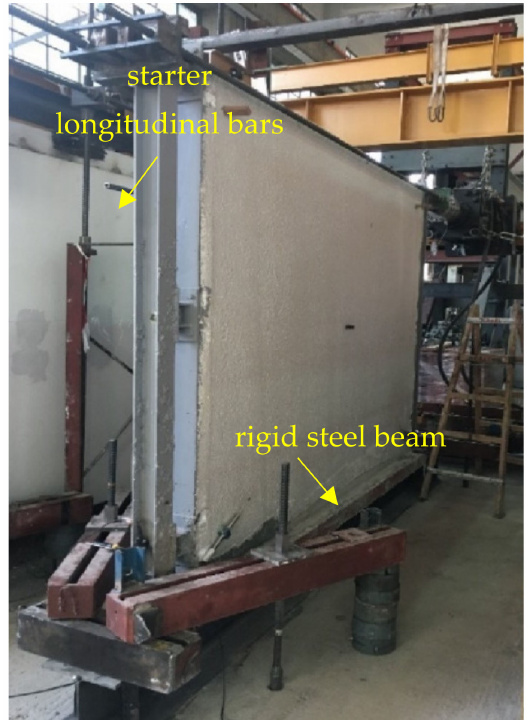
Figure 21. View of the of the PCSP-ISF model and its test support conditions.